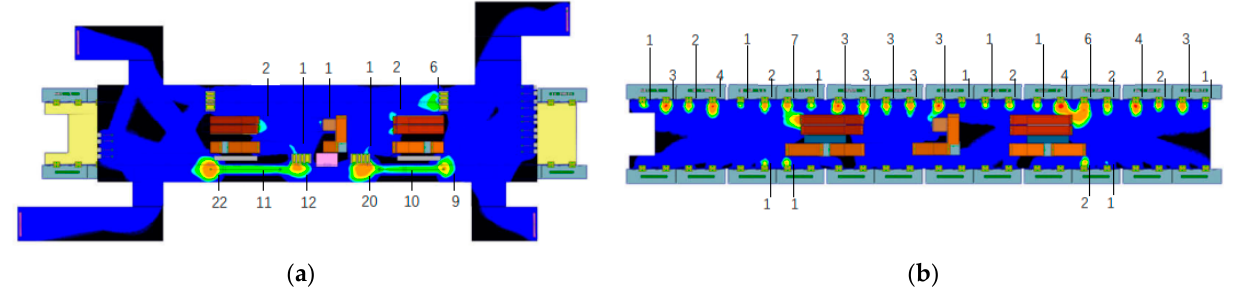
Figure 9. Simulation results of pedestrian spatial density at two floors: ( a ) Concourse floor; ( b ) Plat- form floor.